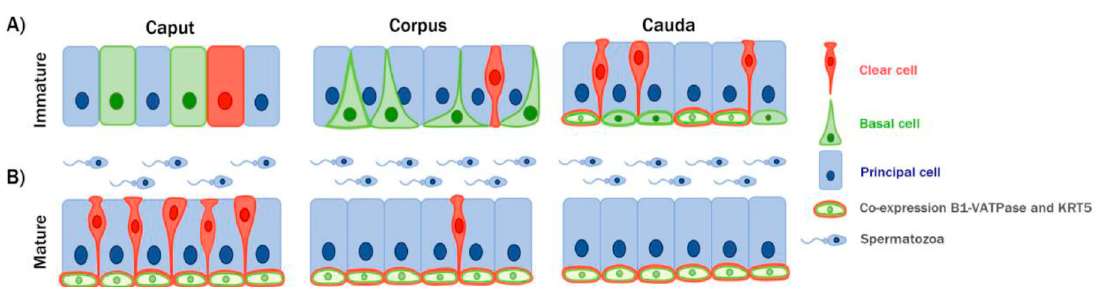
Figure 6. Schematic diagram of the epididymal epithelium differentiation in immature and mature goats. ( A ) During the immature stage, in the caput region, all epithelial cells have a similar morphology (columnar shaped). In the corpus region, CCs are goblet shaped and their nuclei begin to migrate to the apical area of the epithelium. Basal cells have narrow- or triangular- shaped cytoplasmic cell bodies and their nuclei begin to migrate to the base of the epithelium. In the cauda region, all CCs are goblet shaped and their nuclei are located in the apical area of the epithelium. All BCs are dome-shaped and located at the base of the epithelium. B1-VATPase is expressed in some BCs. ( B ) During the mature stage, goblet CCs were found in the caput and corpus regions of the epididymis but not in the cauda region. Basal cells located at the base of the epithelium co-expressed KRT5 and B1-VATPase in all regions of the epididymis.